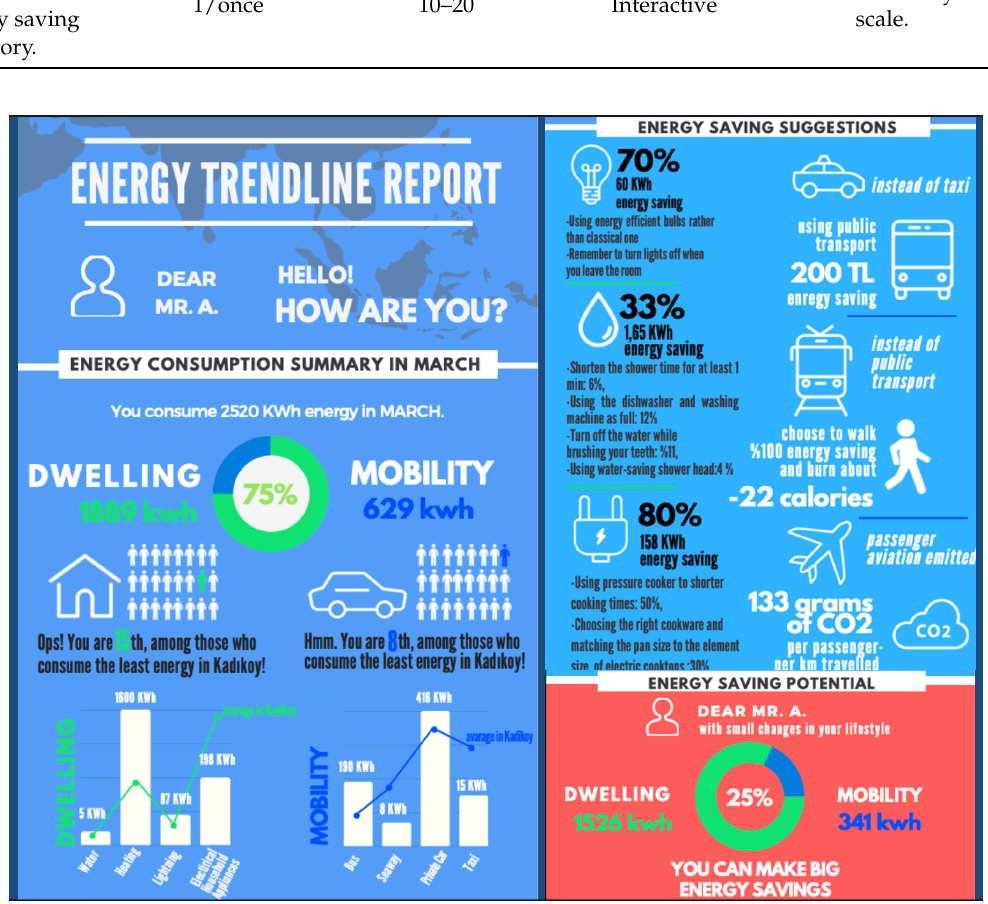
Figure 7. Energy Trendline Report was designed as a part of the feedback and interventions of the